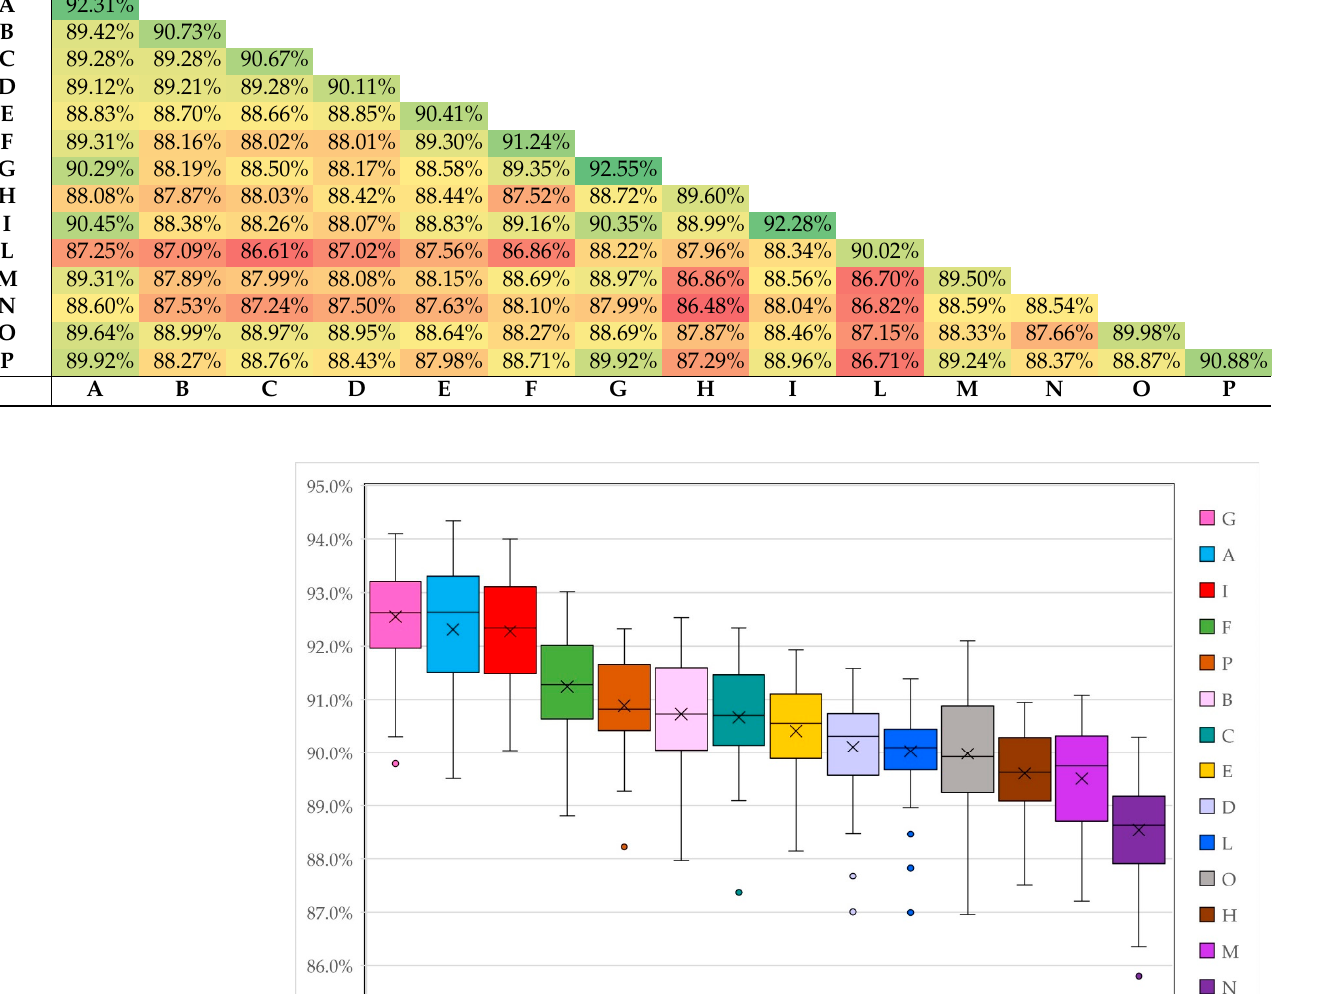
Table 7. Average genetic similarity percentages (GS%) calculated within and among each variety using Rohlf’s simple matching coefficient. Red and green indicate lower and higher GS%, respectively.